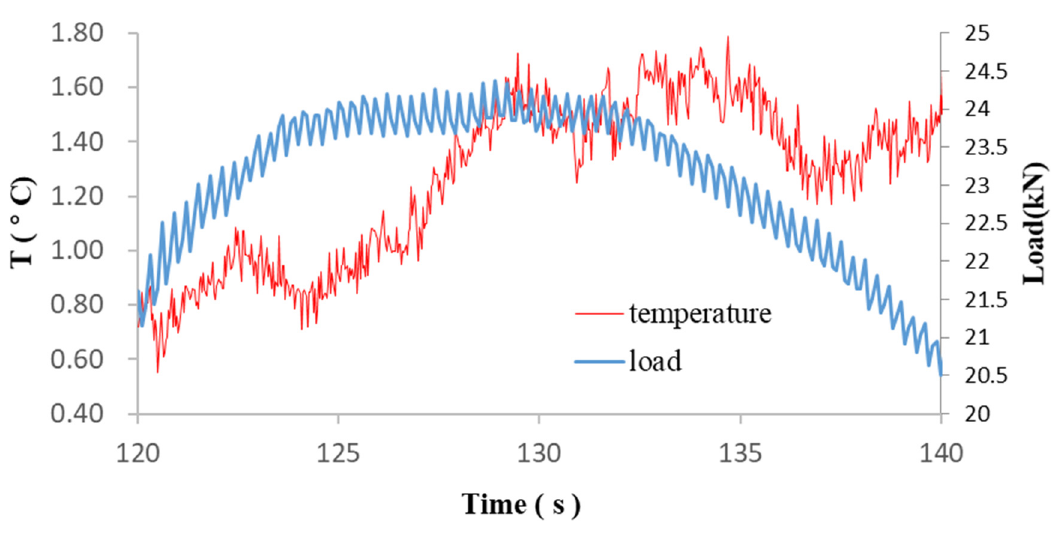
Figure 14. Variation of load and temperature with time at crack point I1.